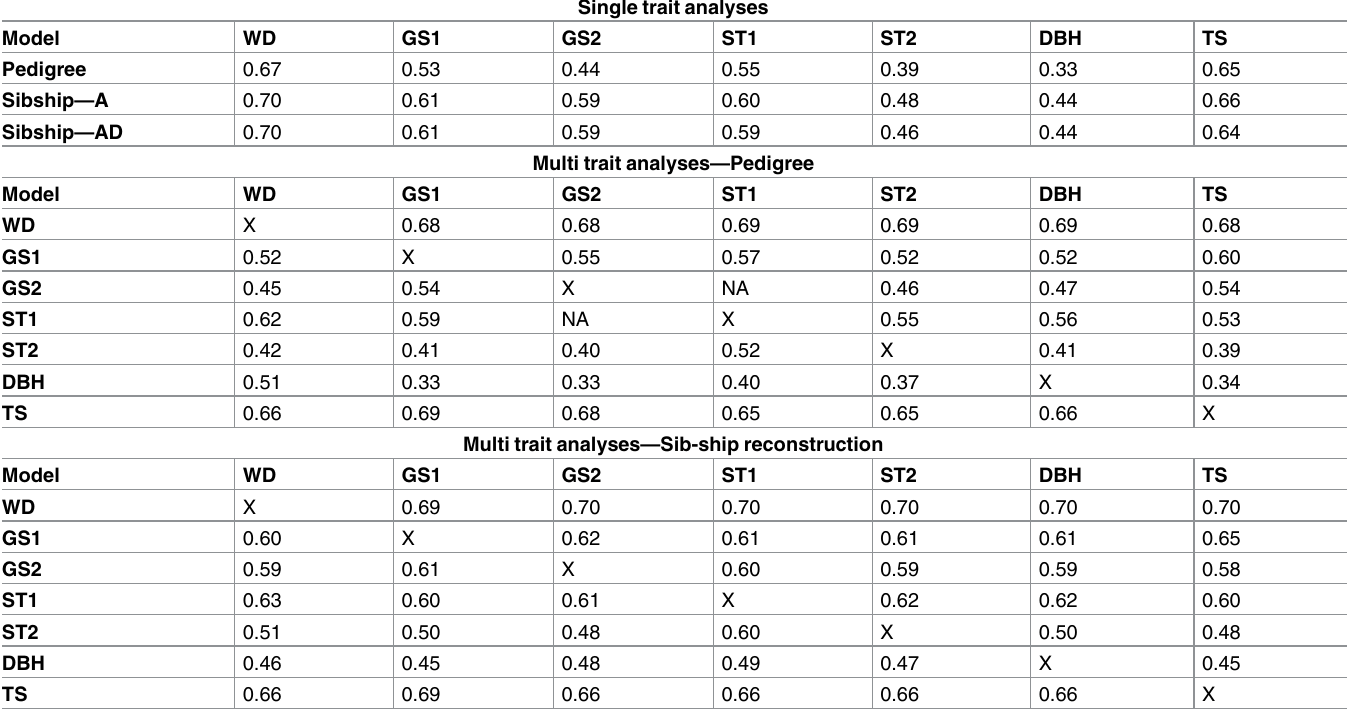
Table 2. Accuracyof breeding values estimated in single trait model, multi-trait model based on documented pedigree and multi-trait model based on information from sib-ship reconstruction. Single trait analyses